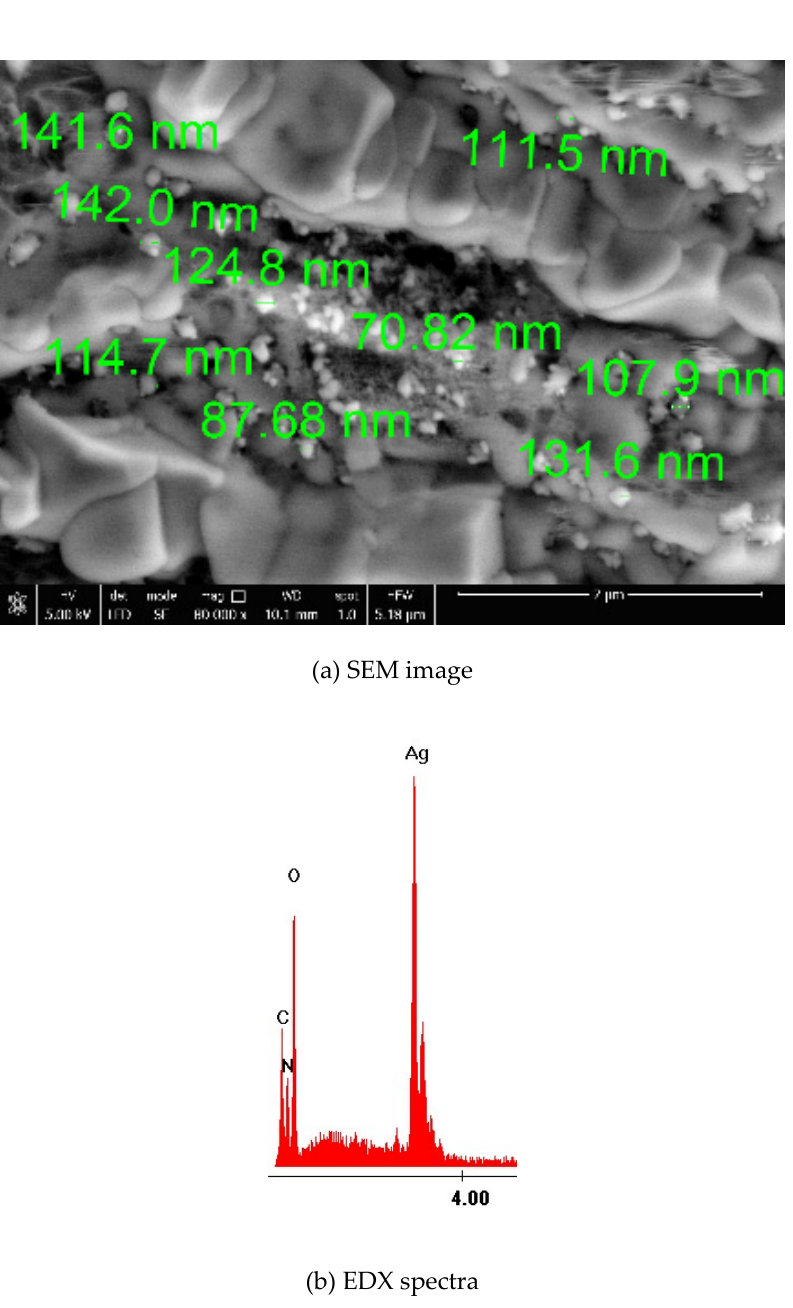
Figure 5. SEM image ( a ) and Energy Dispersive X-ray (EDX) spectra ( b ) for synthetized colloidal silver.